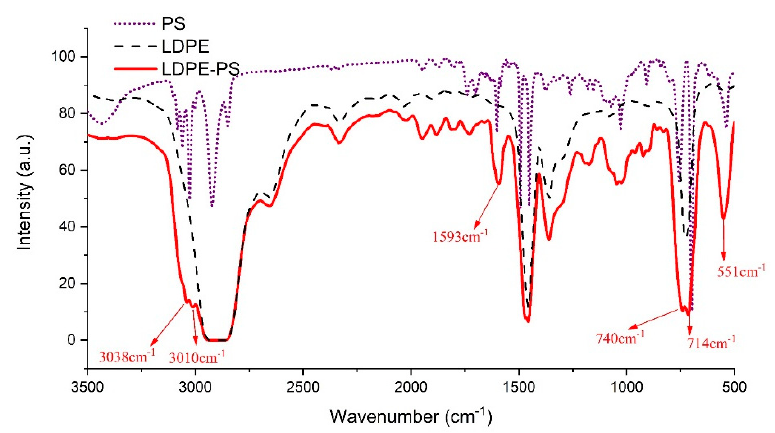
Figure 4. The Fourier-transform infrared spectra of LDPE, PS, and LDPE-g-PS.